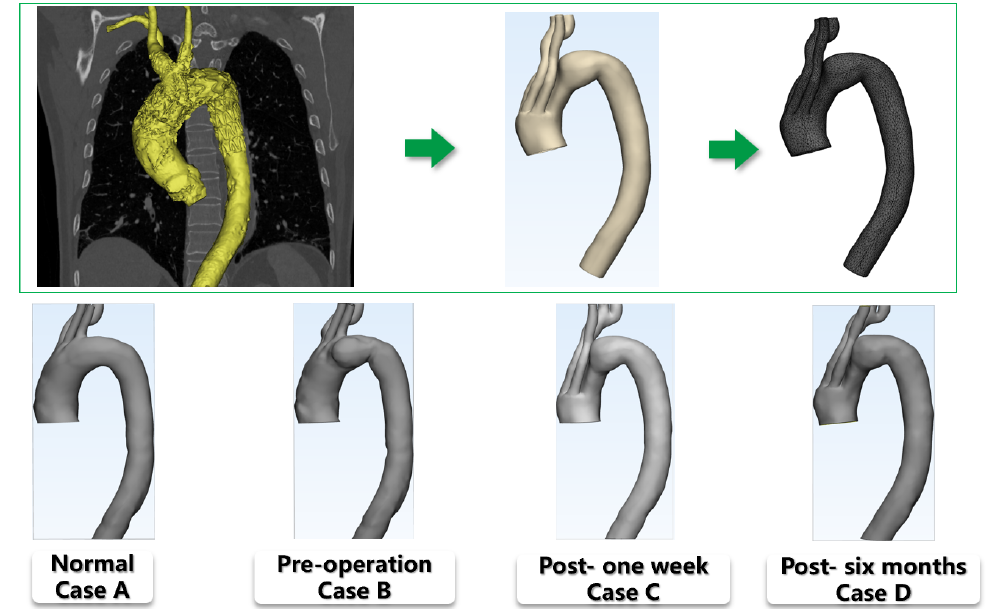
Figure 2. Top: Three-dimensional model reconstruction and mesh generation. (Case A ) Normal geometry; (Case B ) Preoperative geometry; (Case C ) 1-week postoperative geometry; (Case D ) 6-month postoperative geometry.